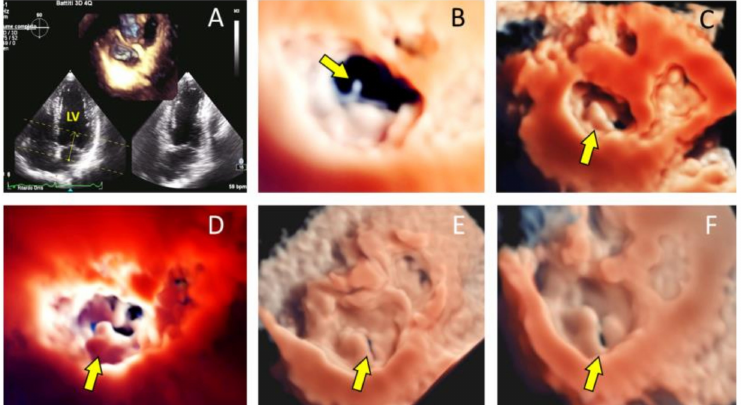
Figure 1. Transillumination techniques in mitral valve prolapse. ( A ): Four-chamber view showing (arrow and area of interest included in the 2 yellow lines) how to visualize the surgical view of the MV; ( B ): example of visualization of a chordal rupture (arrow) from the surgical view; ( C ): loculated P2 prolapse (arrow); ( D ): large P2 prolapse (arrow); ( E , F ) early- and mid- systolic frames of a P2 prolapse associated with a cleft P2/P3